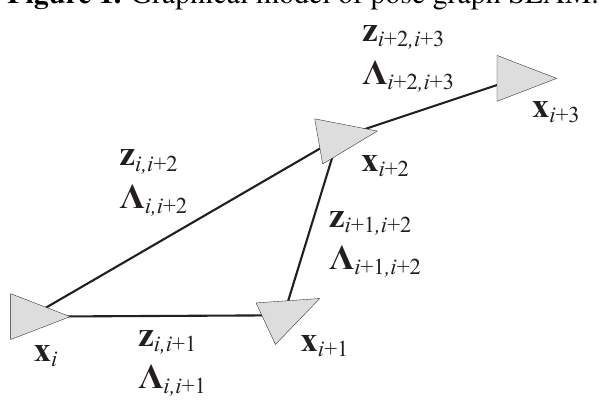
Figure 1. Graphical model of pose graph